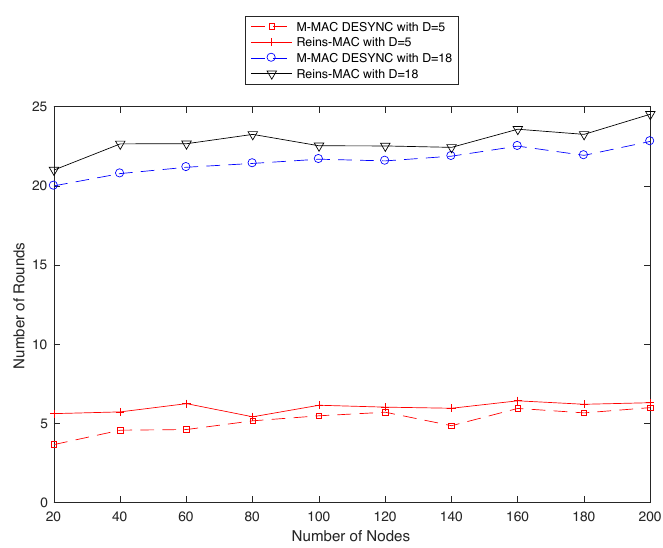
Figure 10. The average number of convergence rounds in different size of